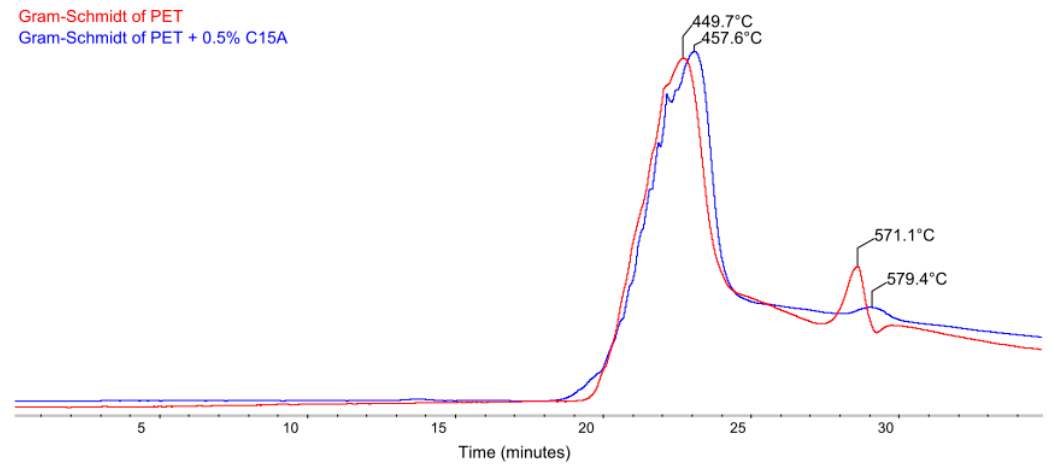
Figure 10. Gram-Schmidt curves of pure PET (red) and PET modified with 0.5% C15A (blue).